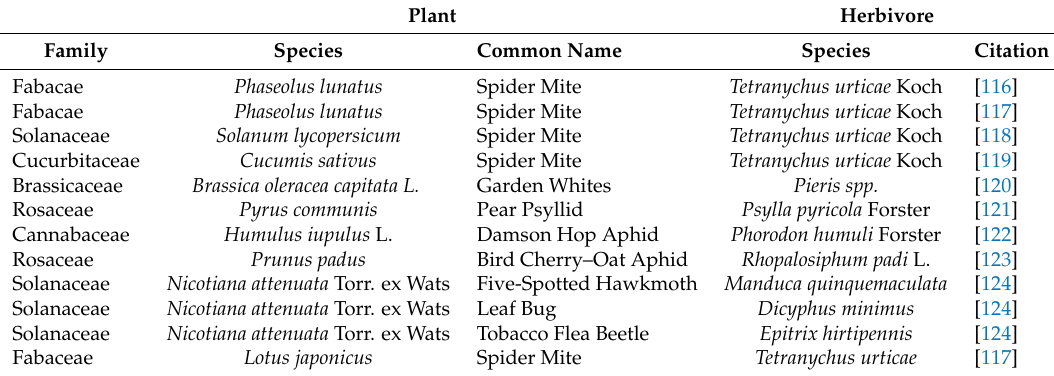
Table 1. MeSA released from listed plant species in a blend of herbivore released plant volatiles after feeding by listed herbivore